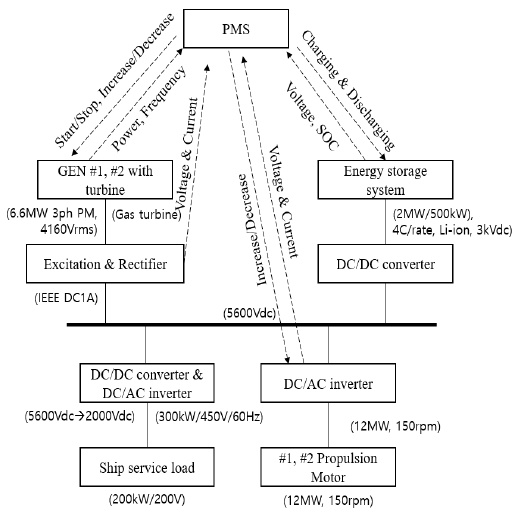
Figure A5. Relationship with parameters for PMS.